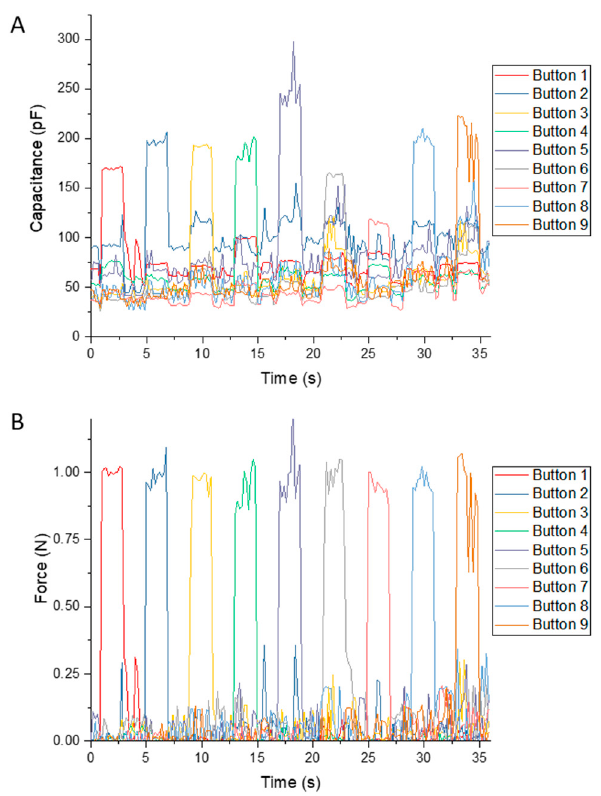
Figure 5. The response of the force-sensing array and its calibrated results. ( A ) The response of the force-sensing array to a load of 1 N placed on individualized buttons/sensors; ( B ) the calibrated results of the force sensing-array rebuilt by Tikhonov regularization.